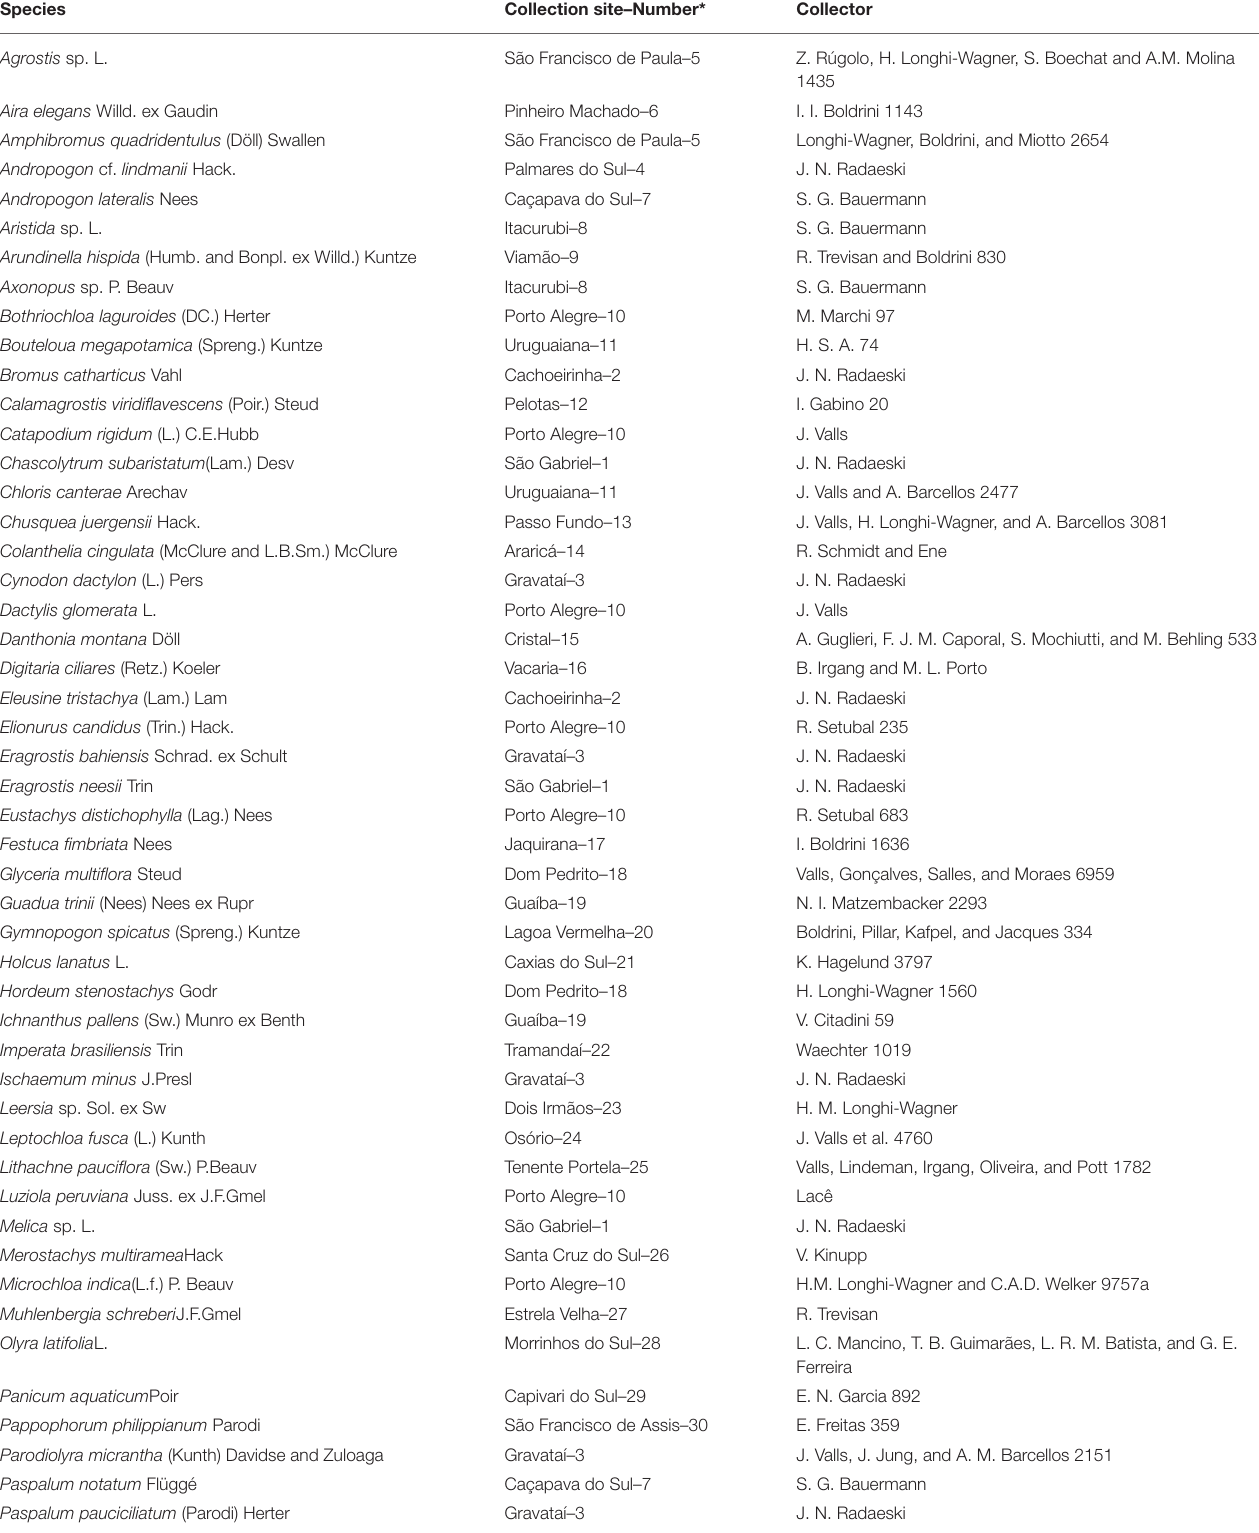
TABLE 2 | Information of the examined material in the Rio Grande do Sul,